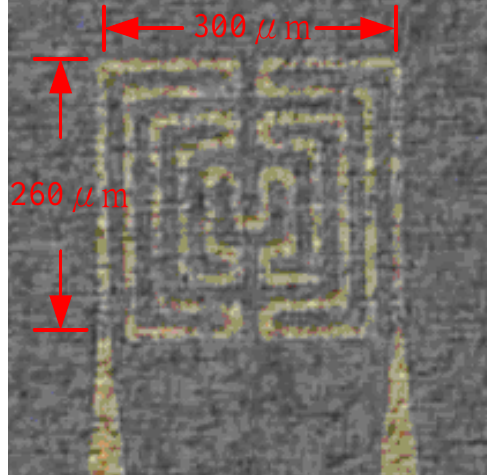
Figure 6. Optical microscope picture of a micro temperature